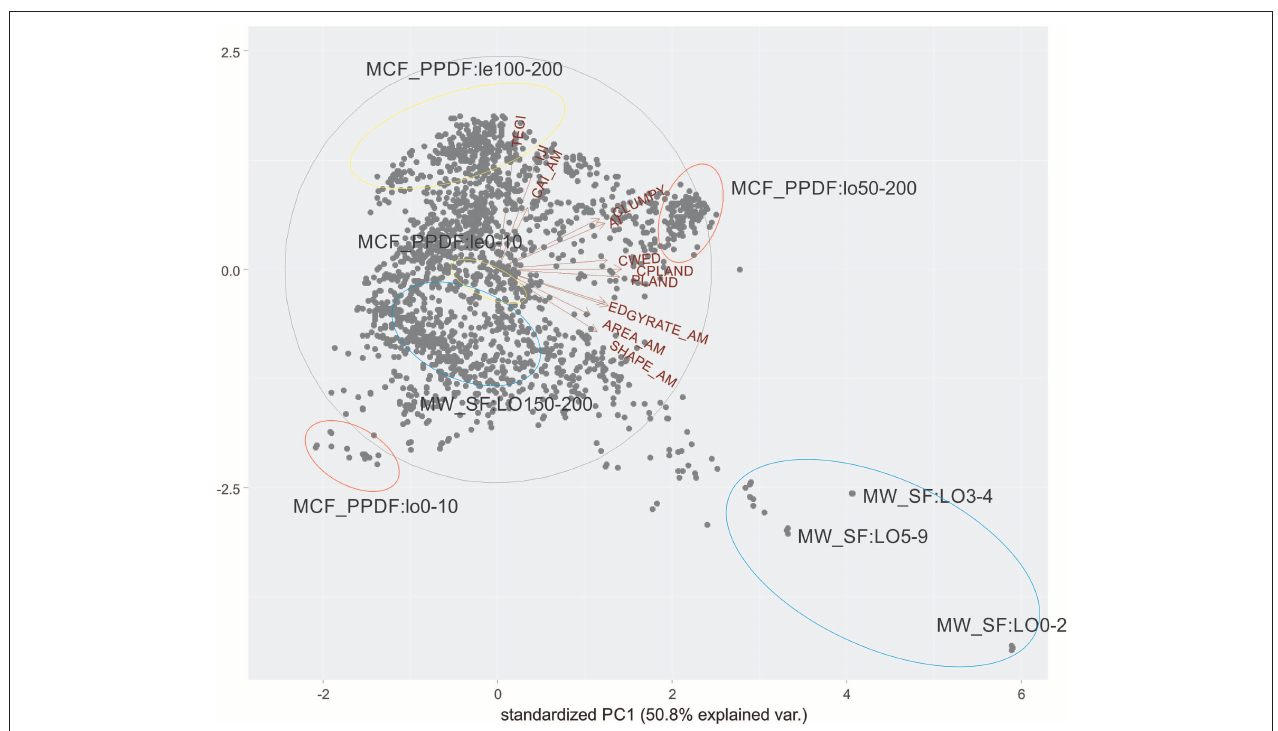
FIGURE 8 | Multi-temporal principal components analysis of class-level metrics in the Prospect Creek watershed across the simulation time. Gray dots are combinations of cover type at a given seral stage at a given simulation time step. The gray ellipse contains 95% of the simulated range in landscape structure space. The red vectors represent the direction of increase of each landscape metric and metric acronyms are labeled at the end of each vector. The blue ellipses show cover-seral conditions for two cover types (Mixed-Conifer Ponderosa Pine-Douglas Fir Late Seral Open Canopy - NCF_PPDF; Mesic-Wet Spruce-Fir Late Seral Open Canopy - MW_SF) at early and late simulation times. Simulation times are indicated by the numbers at the end of the acronym. For example, MCF_PPDF:lo0-10 ellipse encloses the initial condition and first ten time steps of the Mixed-Conifer Ponderosa-Pine Douglas Fir Late Seral Open Canopy cover-seral class in landscape structure space. TECI, Total Edge Contrast Index; IJI, Interspersion and Juxtaposition Index; CAI_AM, Area-weighted Core Area Index; CLUMPY, Clumpy Index; AI, Aggregation Index; CWED, Contrast Weighted Edge Density; CPLAND, Core Area Percentage of the Landscape; PLAND, Class Percentage of the Landscape; ED, Edge Density; GYRATE_AM, Correlation Length; AREA_AM, Area-weighted Mean Patch Size; SHAPE_AM, Area-weighted Shape